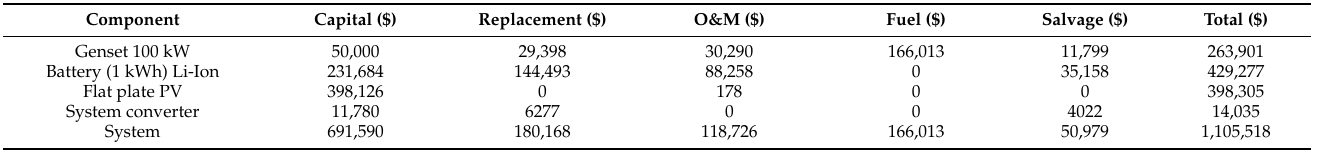
Table 8. System architectural costs for proposed hybrid system for option